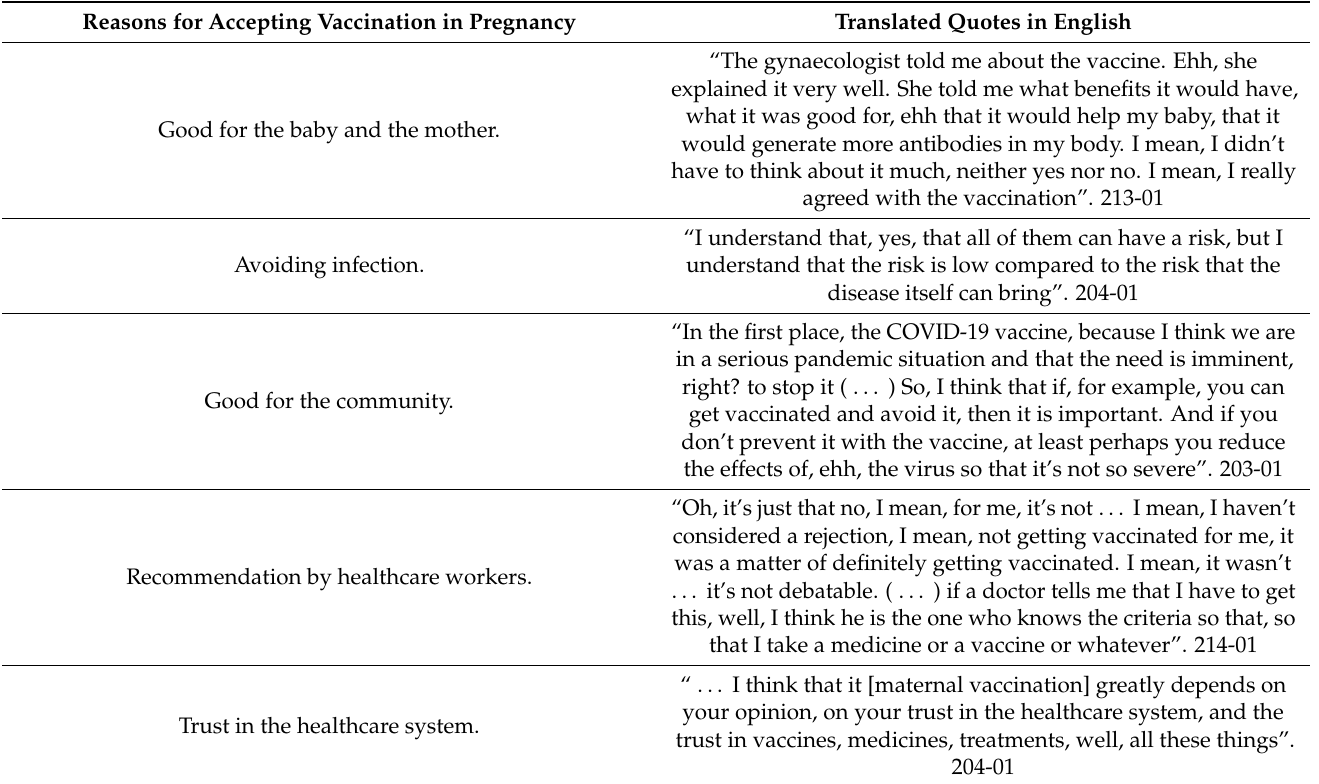
Table 2. Motivational factors for deciding to be vaccinated during